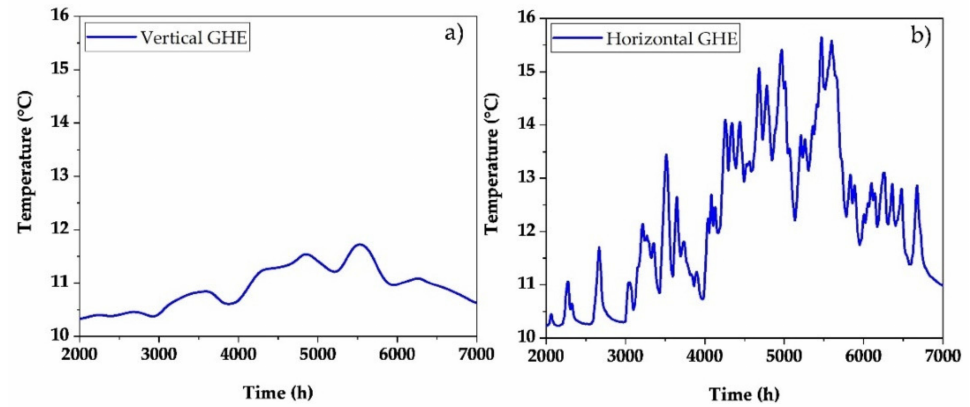
Figure 6. Flow temperature profiles for a vertical ( a ) and a horizontal ( b ) GHE during the cooling season. LCOH and LCOC for LTDH providing heating and passive cooling were